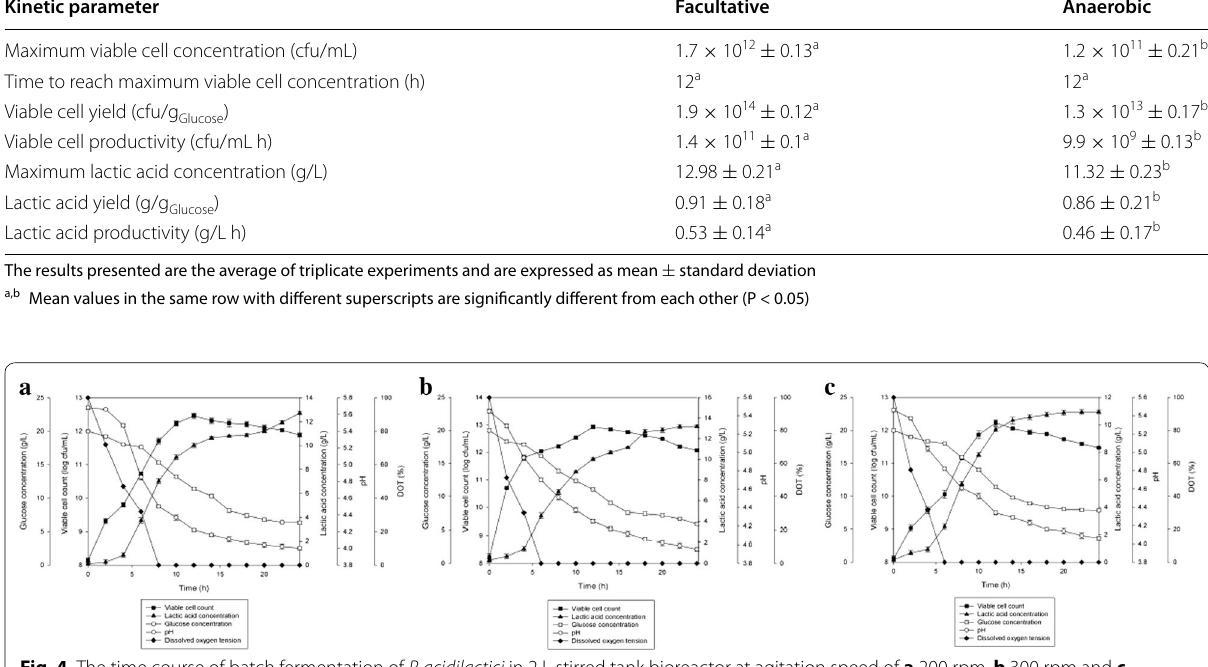
Table 3 Effect of aeration on growth of P. acidilactici in batch fermentation using 2 L stirred tank bioreactor